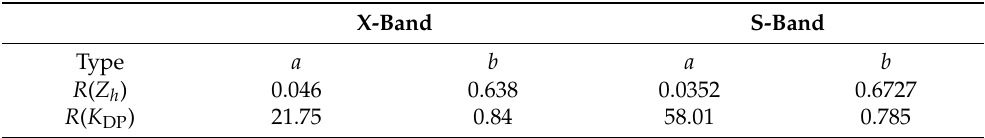
Figure 3. A comparison between the R ( K DP ) and the intrinsic rainfall rate R cal directly observed by the 2DVD for X-band ( a ) and S-band ( b ).